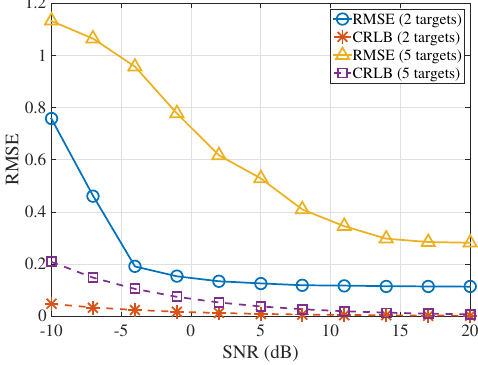
Figure 4. The estimation performance with different numbers of targets.